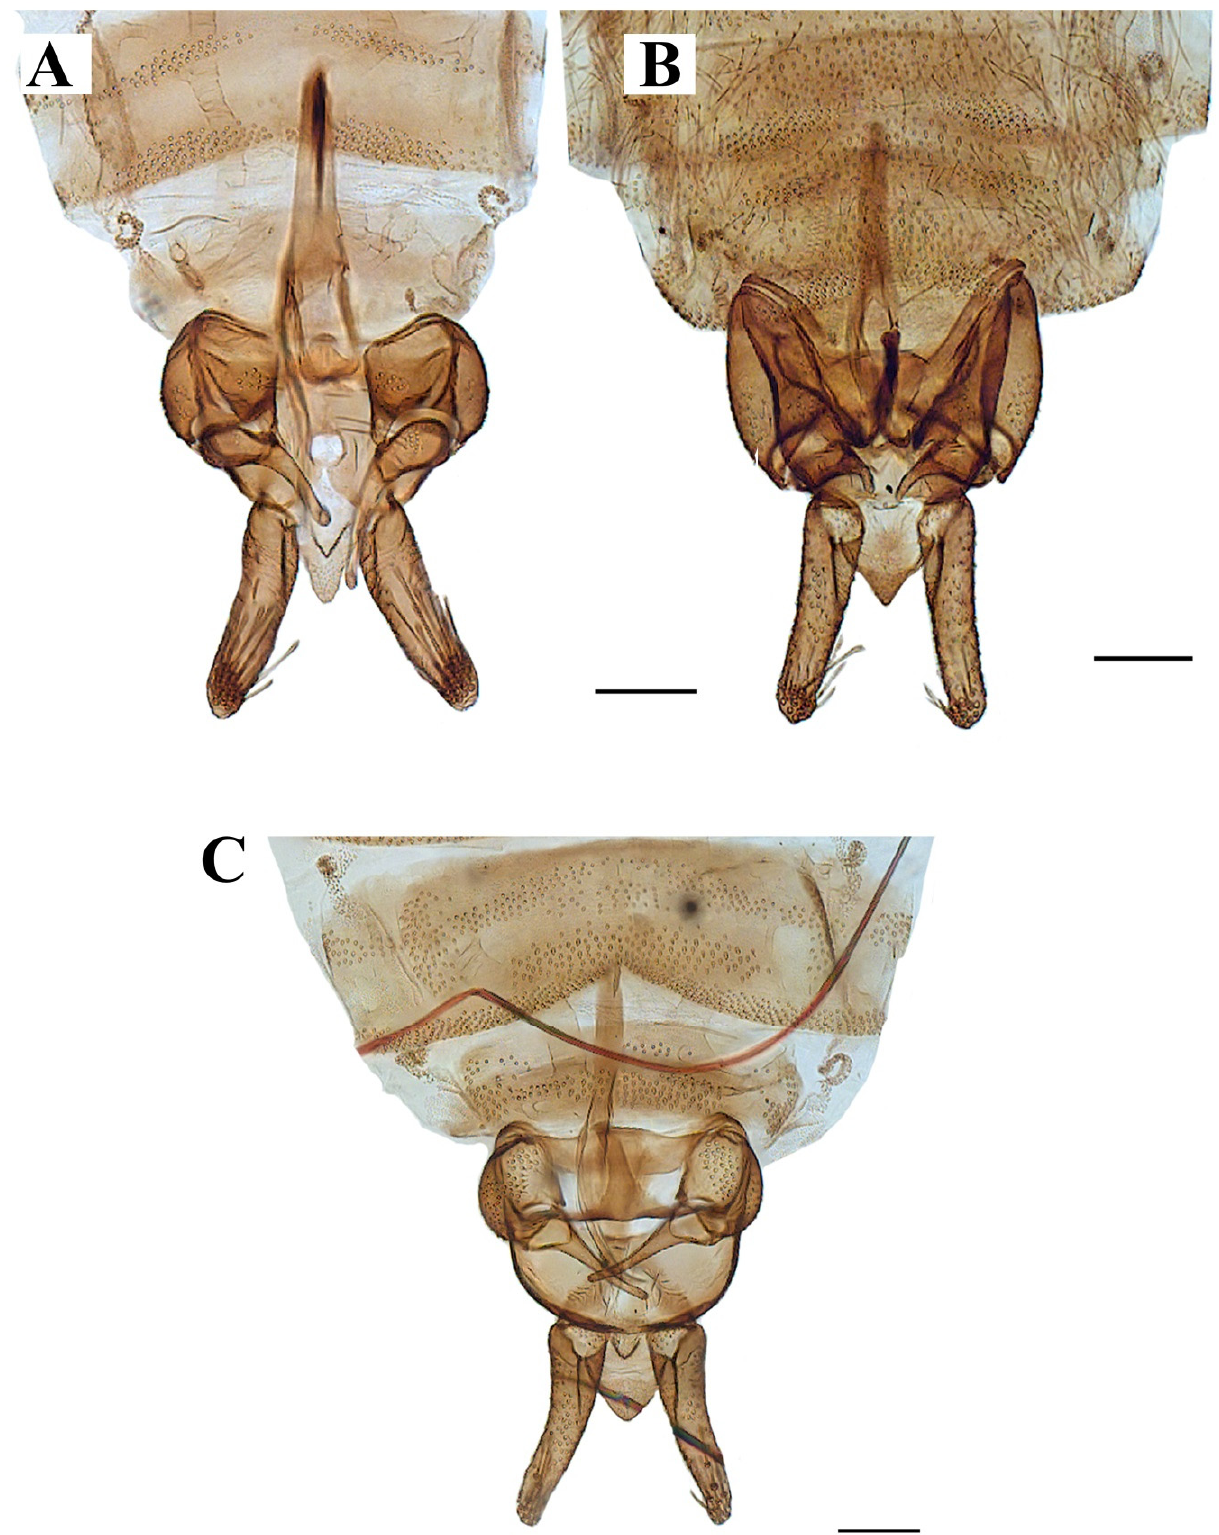
Figure 9. Genitalia of: ( A ) Lepiseodina tristis (Meigen, 1830), ( B ) Lepiseodina rothschildi (Eaton, 1912), ( C ) Lepiseodina latipennis (Sarà, 1953). Scale ( A – C ) in millimeters (mm), scale lines = 0.10 mm.